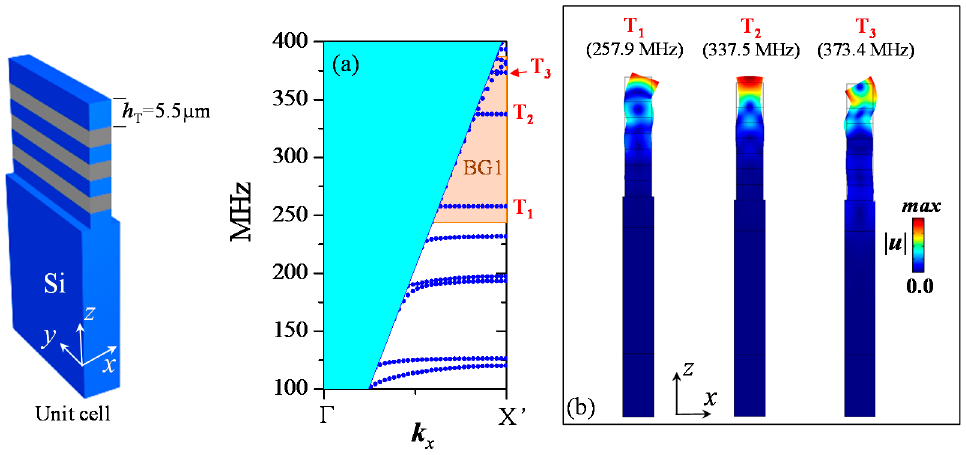
Figure 4. ( a ) Band structure for PC system composed of phononic ridges with thickness of the top Si layer h T = 5.5 µm. ( b ) Total displacement field amplitude |u| for the confined modes inside the band gaps at X’ point.